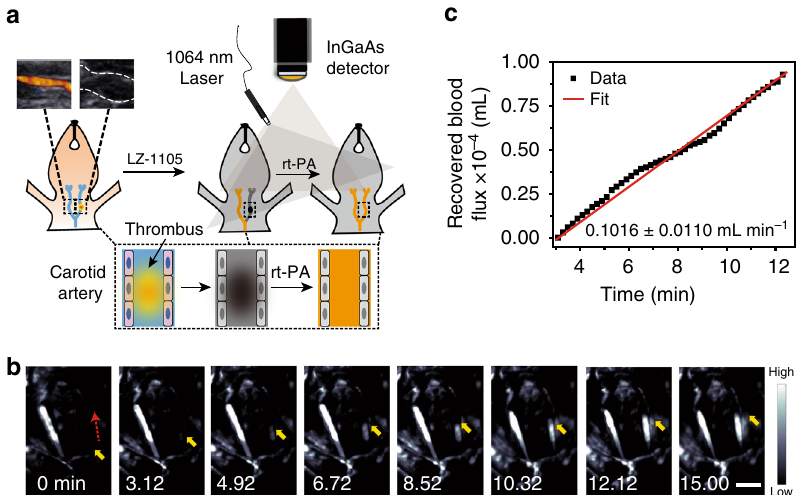
Fig. 4 Real-time NIR-II imaging of the thrombolysis process in carotid artery. a Schematic illustration of the thrombolysis process. Inset: Ultrasonic imaging of carotid artery without (left) and with (right) thrombus, demonstrating successful formation of a thrombus in the right carotid artery ( n = 3 mice). b NIR-II bioimaging of the carotid artery performed by LZ-1105 at various time points p.i. of recombinant tissue plasminogen activator (rt-PA) administration (1400 nm long-pass, λ ex = 1064 nm, 300 ms). The red dashed and yellow solid arrows indicate the blood fl ow direction and signal front, respectively. c Recovered blood fl ux during thrombolysis process as a function of time. The slope of the function was calculated as the recovered blood fl ux rate in thrombolysis and indicats mean ± s.d. derived from n = 3 replicated measurements. Scale bar represents 3 mm. Source data underlying c is provided as a Source Data fi